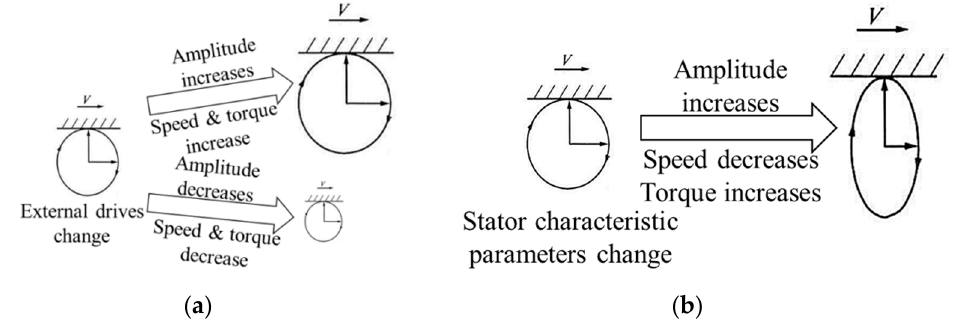
Figure 3. Comparison of the effects of changing external drives and changing the stator characteristic structure on elliptical motion: ( a ) change of external drives and ( b ) change of stator characteristic structure.